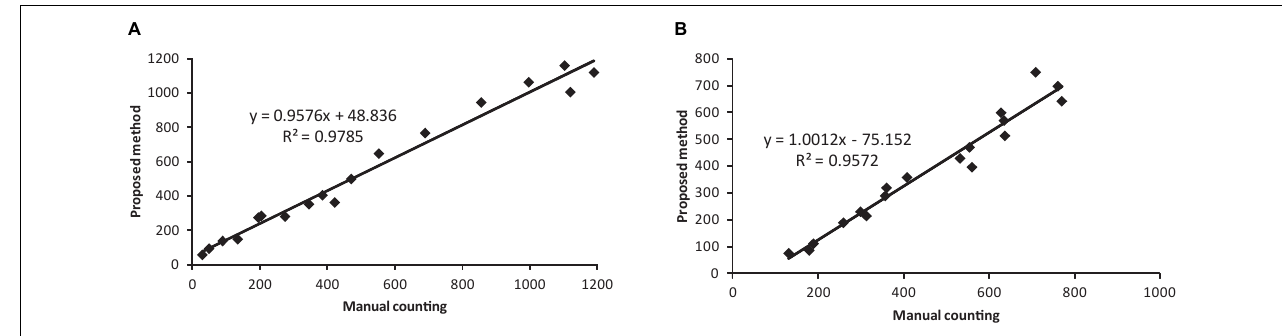
FIGURE 10 | Comparison of results between the proposed detection method and manual counting for (A) whitefly and (B) thrips using the testing dataset.